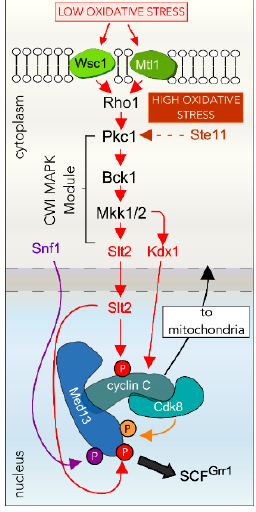
Figure 3. Outline of the Cell Wall Integrity (CWI) signal transduction pathway that mediates cyclin C translocation to the cytoplasm following low oxidative stress (0.4 mM H 2 O 2 ). Both the MAPK of this pathway (Slt2) and its pseudo-kinase partner, Kdx1 are required for the efficient export and degradation of cyclin C. Cyclin C release is dependent upon Med13 degradation by the SCF Grr1 E3 ligase complex, triggered by Cdk8, Slt2 and the AMPK Snf1-mediated phosphorylation. Following high levels of oxidative stress (1.2 mM H 2 O 2 ) the activity of Ste11, the MAPKKK of the HOG signal transduction pathway is also required. For clarity, Ask10 and Plc1, which also play roles in cyclin C’s fate are omitted from the figure. MAPK—mitogen activated protein kinase, SCF—Skp1-Cullin-F-box-protein, HOG—high osmolarity glycerol, AMPK—adenosine monophosphate-activated protein kinase, P—phosphorylation event.